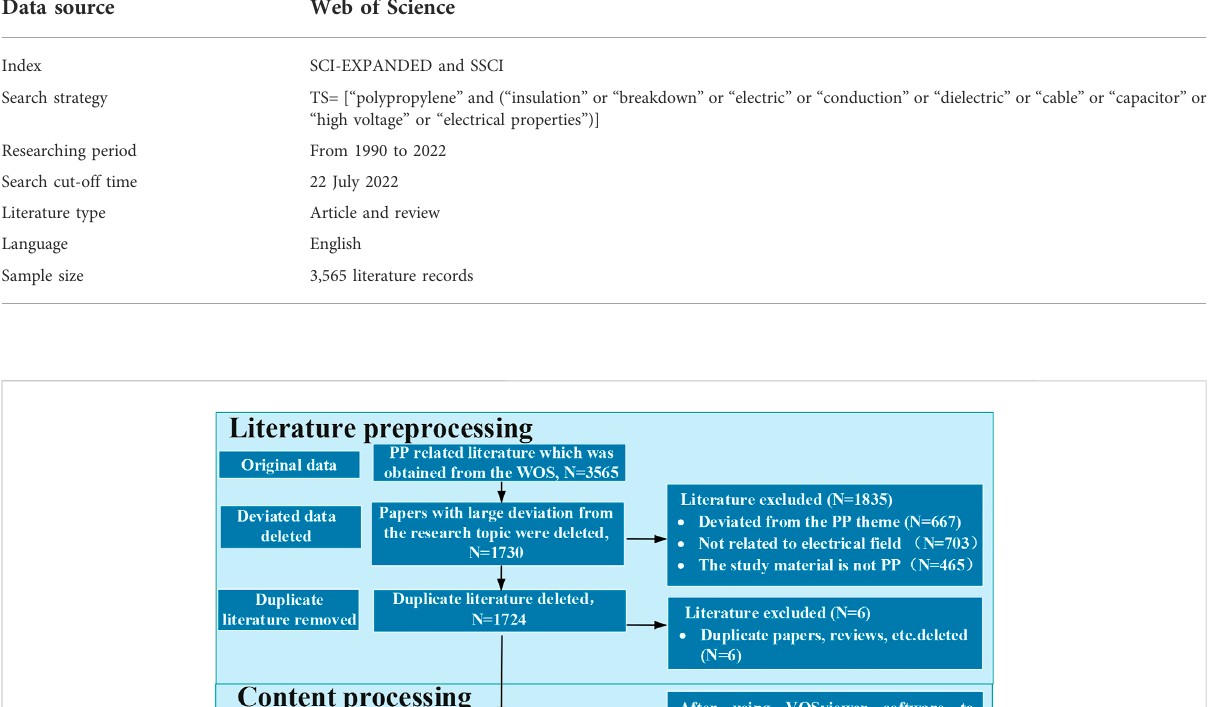
TABLE 2 Data sources and selection methods.